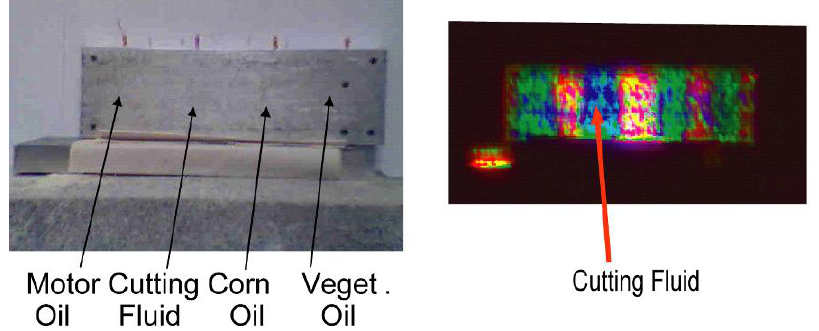
Figure 8. Left: visible image of an aluminum plate contaminated with 4 thin-film stripes of oils. Right: the multi-spectral MIR false-color image showing the oil films as green/blue and the metal as red/yellow. Petrochemical cutting fluid displays a bluish hue that is statistically distinguishable from the organic oils.